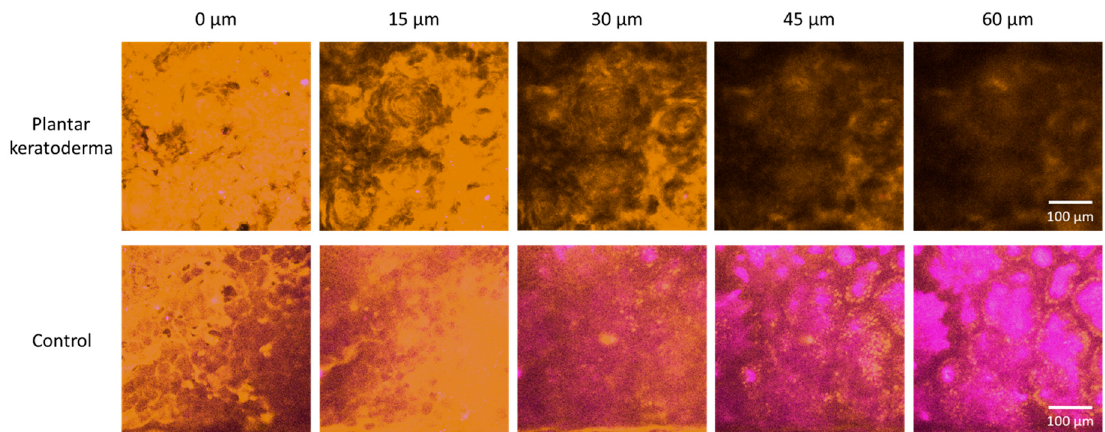
Figure 5. Nonlinear microscopy (NLM) horizontal optical slicing through skin biopsies from the epidermis towards the dermis. Upper panel: plantar keratoderma of the patient lower panel: healthy control. Representative images acquired at five different vertical positions along the z -axis, 15 μ m apart in each case, through the skin biopsies positioned horizontally on the microscopy slides. Orange color (590/45 nm bandpass emission filter) and magenta color (405/20 nm bandpass filter) indicate two-photon absorption fluorescence (TPF) and second-harmonic generation (SHG) signals, respectively, in the imaging plane. Scale bar: 100 μ m. Pixel size: 0.8476 pixels/ μ m.